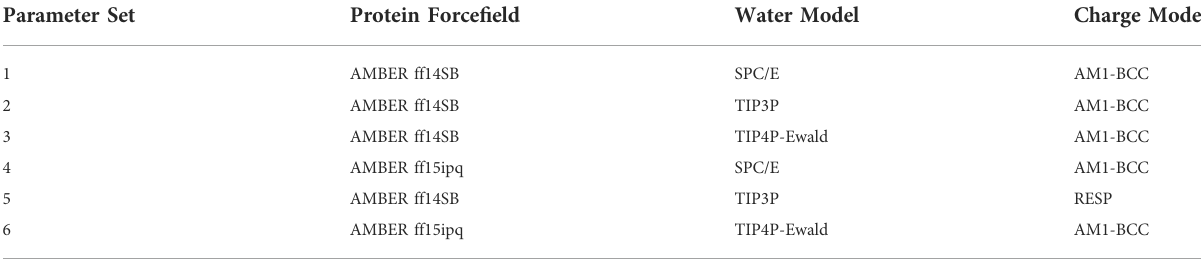
TABLE 1 The fi ve force fi eld parameter sets tested.